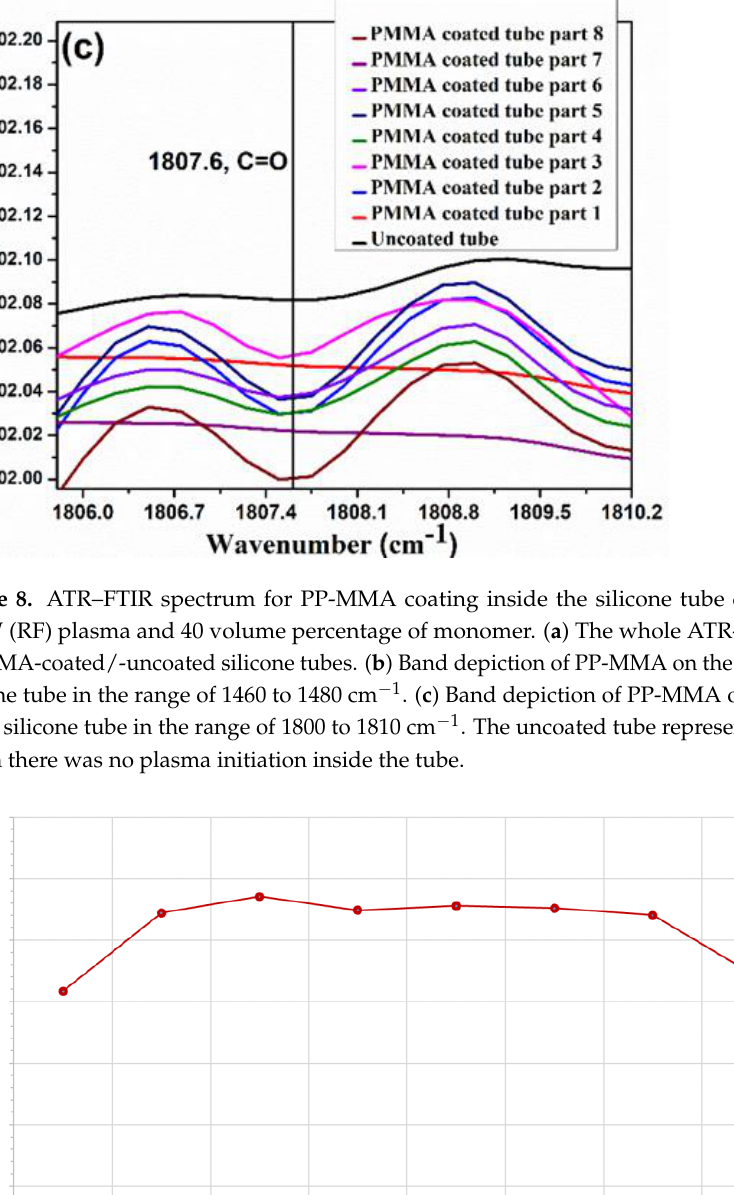
Figure 9. Coating thicknesses of the samples presented in Figure 8 as a function of tube